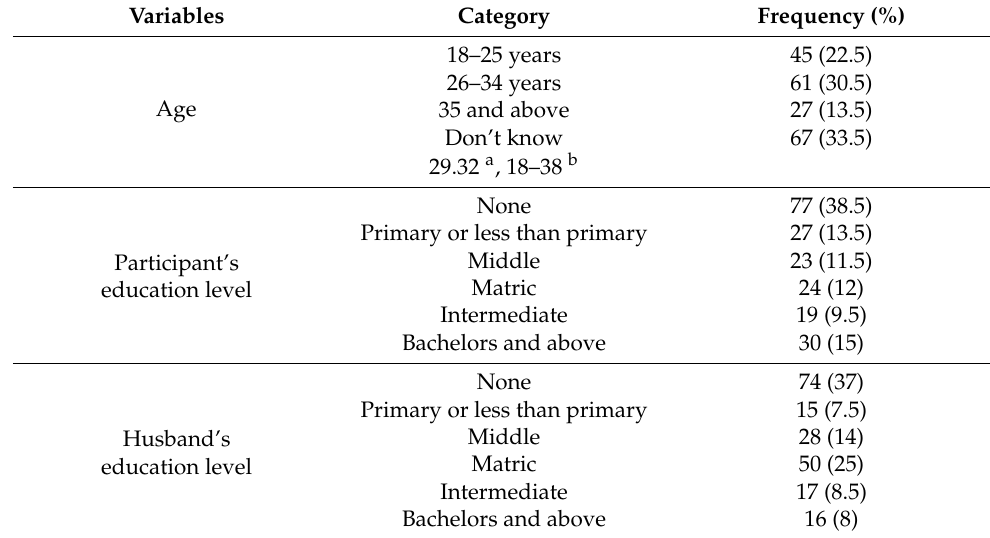
Table 1. Sociodemographic characteristics of study